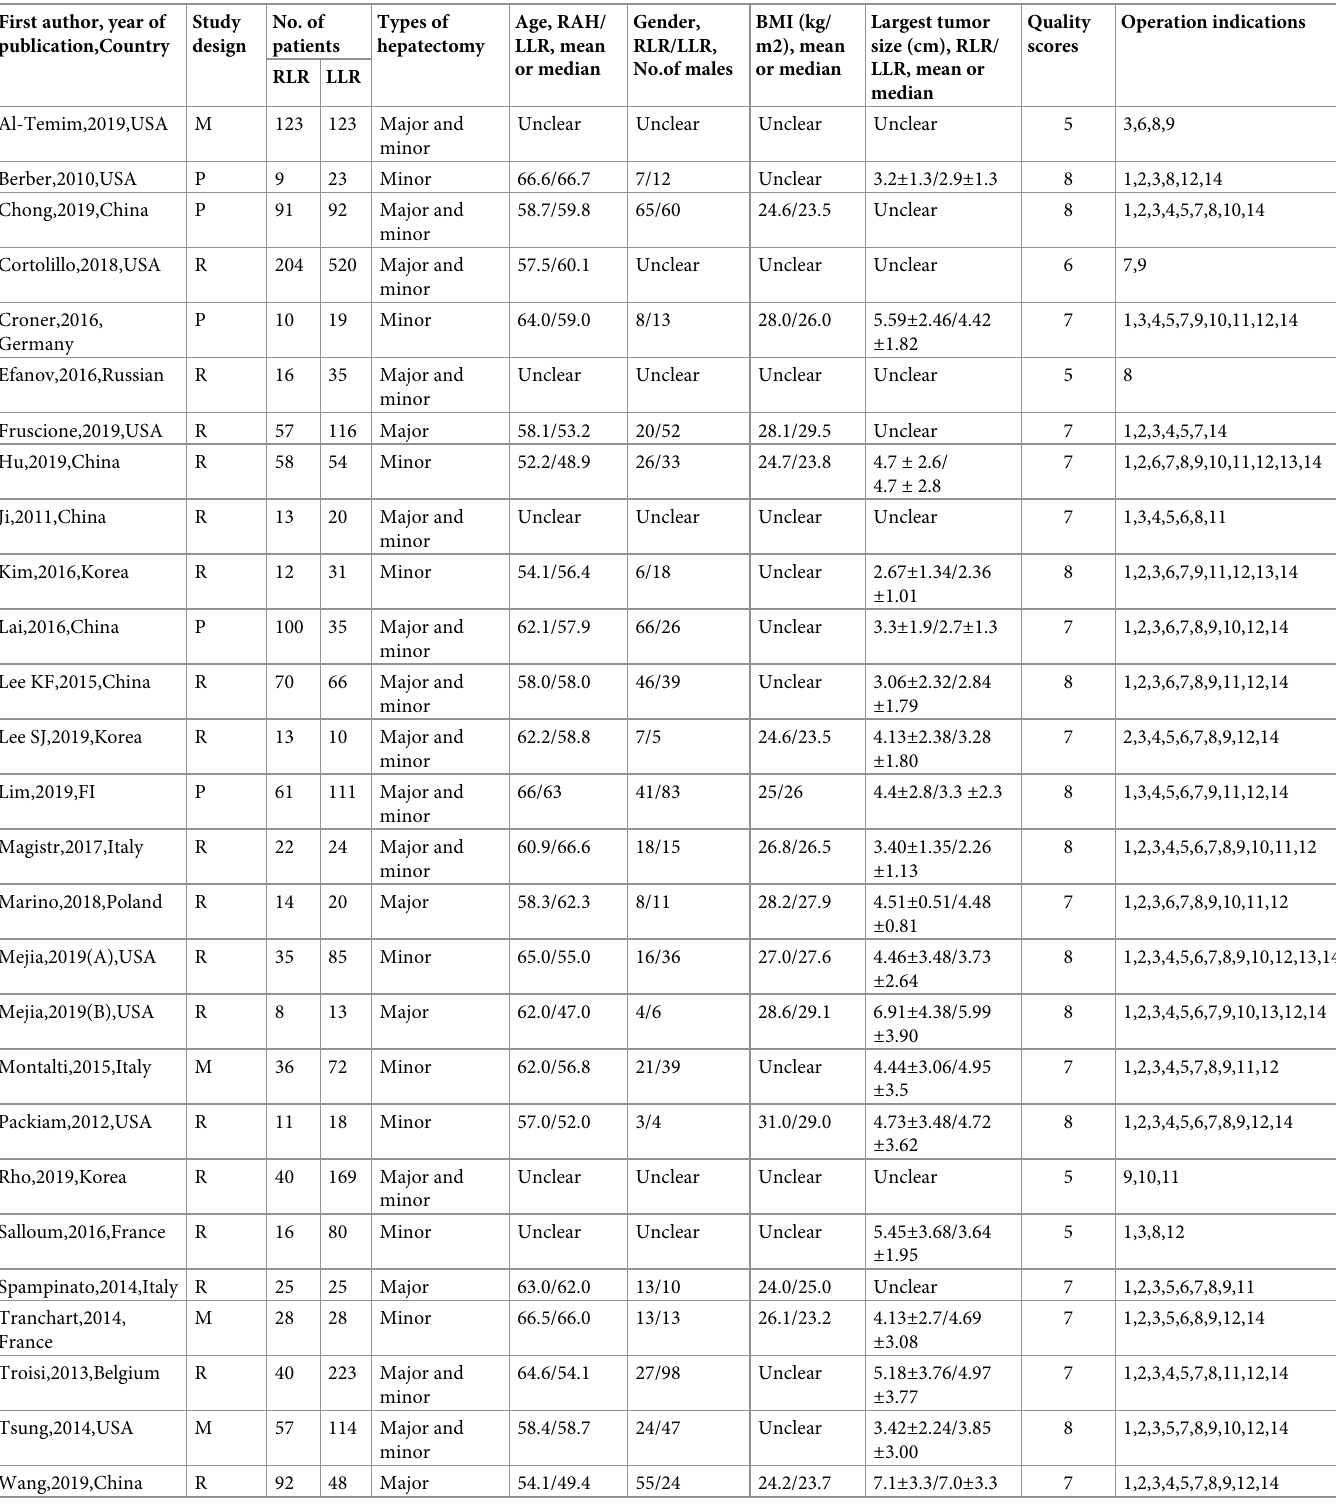
Table 1. Characteristics of the included